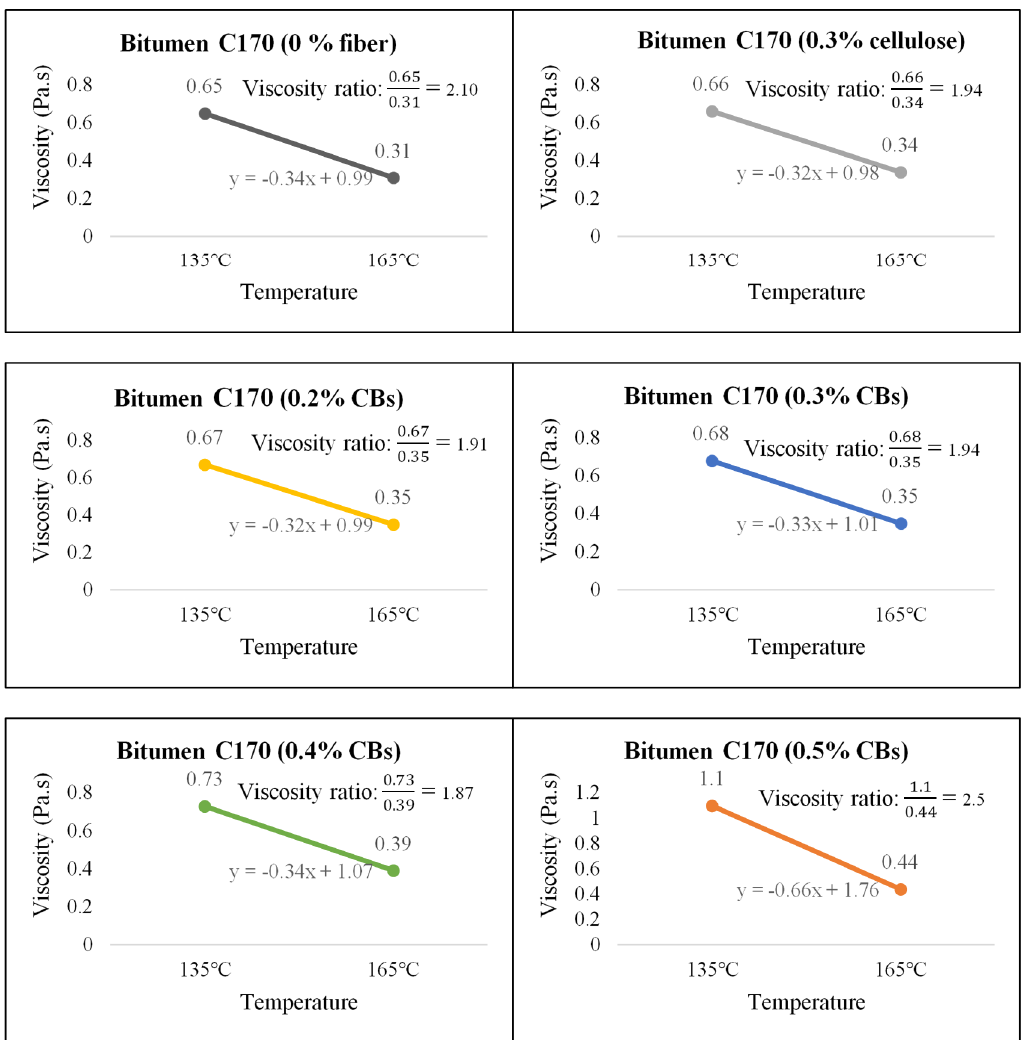
Figure 15. Viscosity ratio and slope of Bitumen C170 with cellulose fiber and di ff erent % of CBs content.